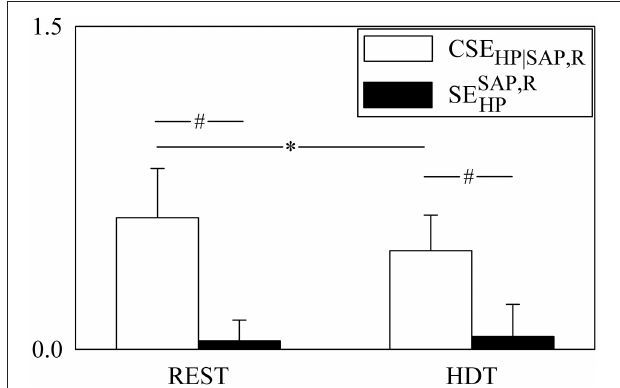
FIGURE 5 | The grouped bargraph shows the CSE HP | SAP,R (white bars) and SE SAP,R HP (black bars) assessed at REST and during